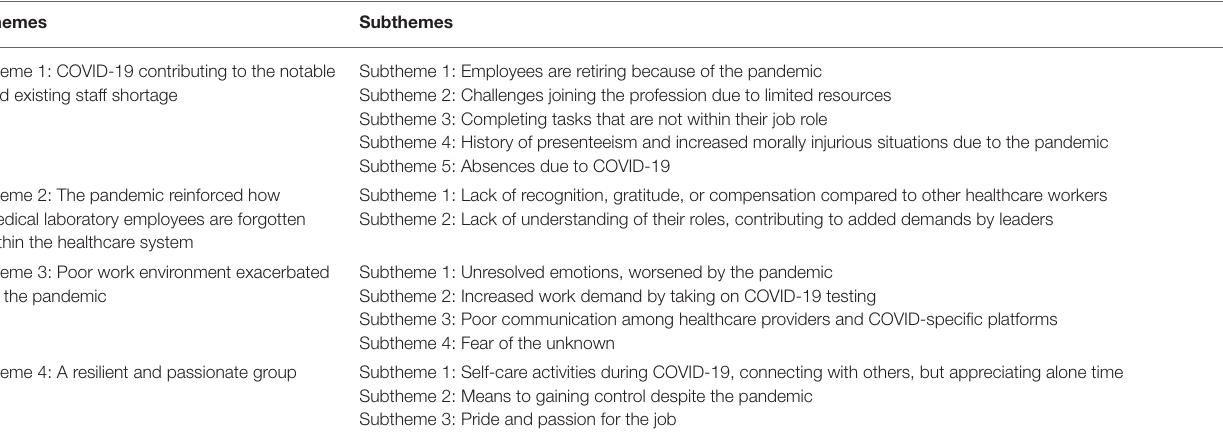
TABLE 2 | Themes and subthemes emerged from focus groups via thematic